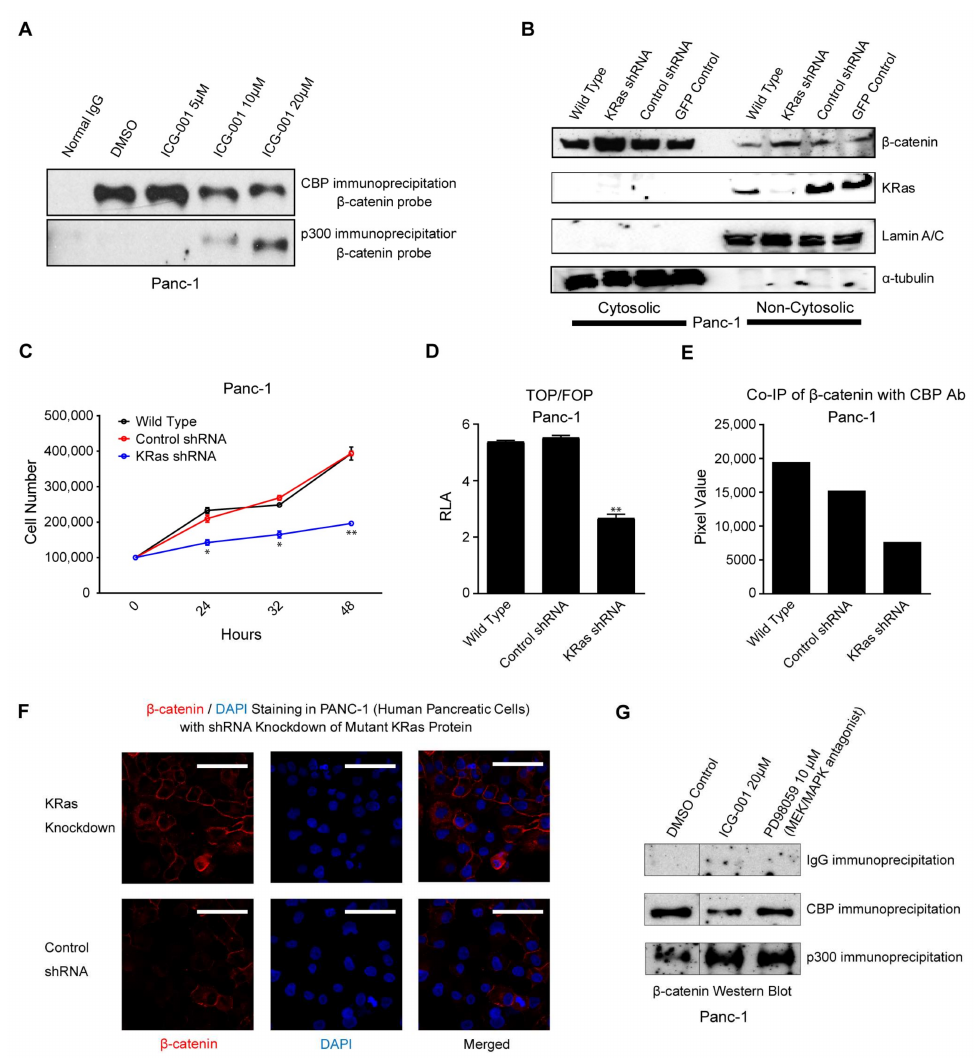
Figure 2. ICG-001 antagonizes CBP/ β -catenin interaction in human pancreatic cancer cells, whereas K-Ras activation increases CBP/ β -catenin interaction. ( A ) Immunoprecipitation of nuclear lysates of PANC-1 cells with CBP specific antibody or p300 specific antibody with subsequent immunoblotting for β -catenin was performed. In the absence of ICG-001, essentially all β -catenin is associated with CBP. Treatment with ICG-001 decreased CBP associated β -catenin with a concomitant increase in β -catenin immunoprecipitated with p300. ( B–F ) K-Ras specific lentiviral shRNA was used to deplete K-Ras in PANC-1 cells. Suppression of K-Ras increased cytoplasmic β -catenin without affecting non-cytoplasmic β -catenin as shown by immunoblot ( B ), decreased cell proliferation, n = 2, * p < 0.05, ** p < 0.01, compared to control ( C ), decreased TOPFlash activity, n = 4 technical replicates, ** p < 0.01, compared to control, RLA, relative luciferase activity ( D ), decreased the amount of β -catenin associated with CBP as shown by co-immunoprecipitation ( E ), and increased membrane-associated β -catenin as shown by immunofluorescence, Scale bar = 100 µ m ( F ). ( G ) Similar to effects of ICG-001, pharmacologic treatment with MEK/MAPK antagonist PD98059 decreased CBP/ β -catenin interaction and concomitantly increased p300/ β -catenin interaction, as assessed by immunoblot. Dividing line indicates splice